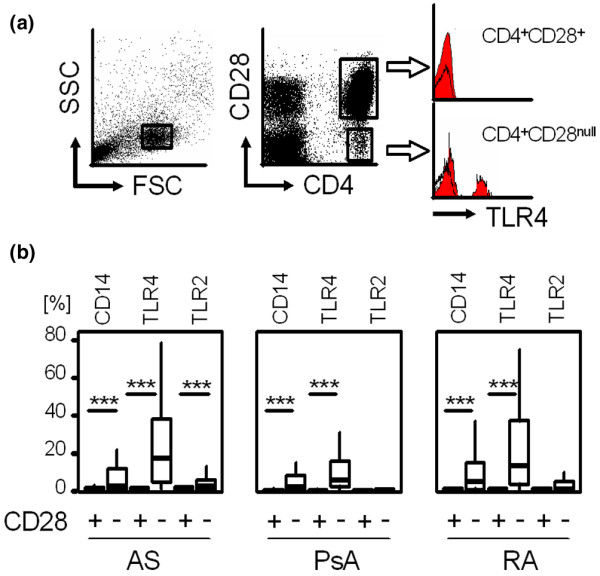
Surface expression of CD14, TLR4 and TLR2 on CD4+CD28+ and CD28null cells in ankylosing spondylitis, psoriatic arthritis and rheumatoid arthritis. (a) Representative dot plots and histograms show TLR4 expression (filled red curve, black line represents isotype control) on CD4+CD28+ and CD4+CD28null T cells. Gates were set on lymphocytes (forward scatter and sideward scatter) as well as on CD28+ and CD28null cells expressing high levels of CD4. (b) Box plots summarize the expression of CD14, TLR4 and TLR2 on CD4+CD28+ and CD28null T cells in patients as indicated. The Wilcoxon test was used to determine the statistical differences between the groups. ***P < 0.001. SSC, side scatter; FSC, forward scatter; AS, ankylosing spondylitis; PsA, psoriatic arthritis; RA, rheumatoid arthritis.